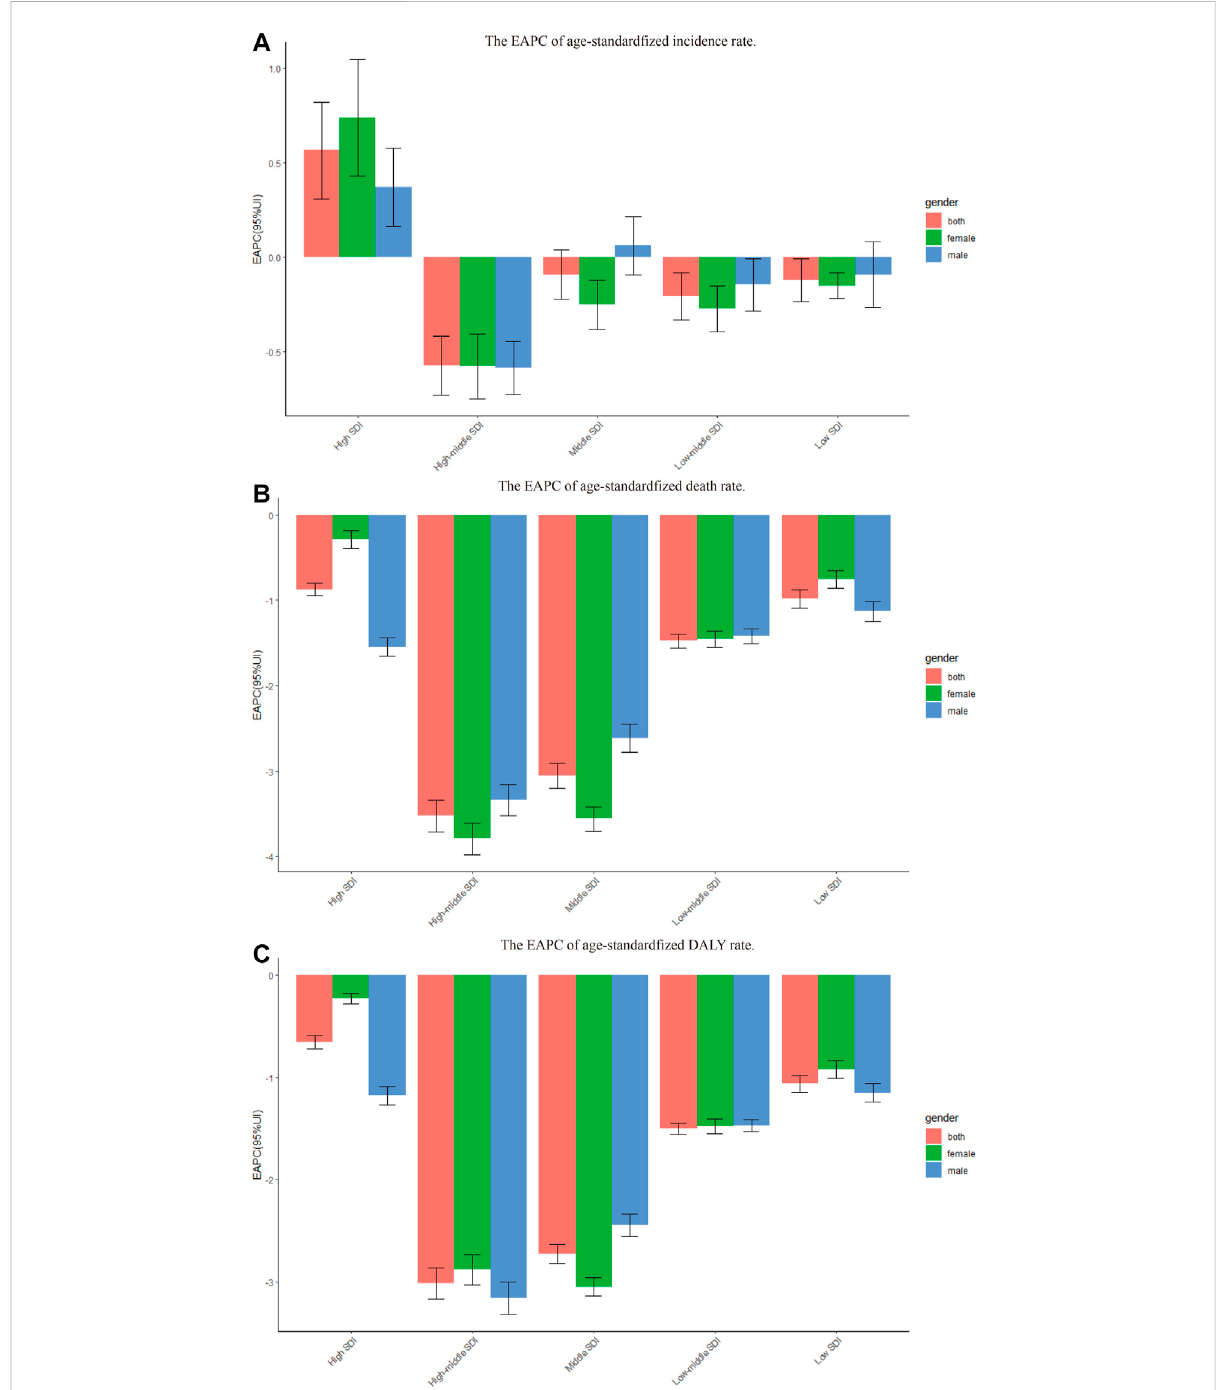
FIGURE 2 The EAPC of chronic obstructive pulmonary disease age-standardized rates from 1990 to 2019, by gender and SDI. (A) The EAPC of age- standardized incidence rate. (B) The EAPC of age standardized death rate. (C) The EAPC of age-standardized DALY rate. EAPC = estimated annual percentage change. DALY = disability adjusted